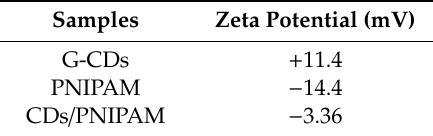
Table 1. Zeta potentials of G-CDs, PNIPAM, and CDs/PNIPAM. Samples